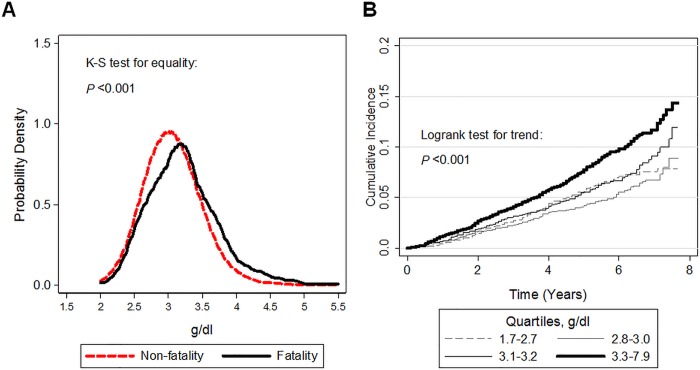
(A) Kernel density plots by vital status with comparison via an unweighted, two-sample, Kolmogorov–Smirnov equality-of-distributions test. (B) Unadjusted Kaplan-Meier cumulative incidence curve with follow-up years as the time axis and all-cause mortality as the outcome stratified by quartiles of baseline gamma gap measurements. Trend across quartiles was determined via the logrank test.